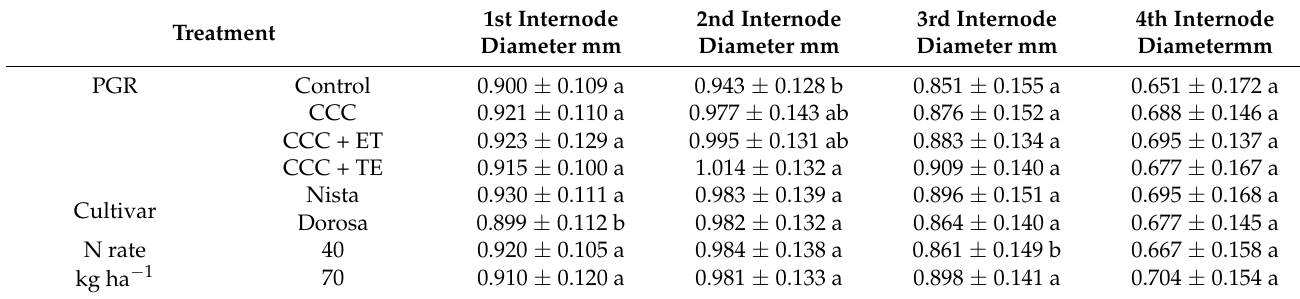
Table 4. Internode diameter of red fescue generative tillers (Festuca rubra ssp. rubra cv. Nista and F. r. ssp. commutata cv. Dorosa), means for two production years, and two field experiments.